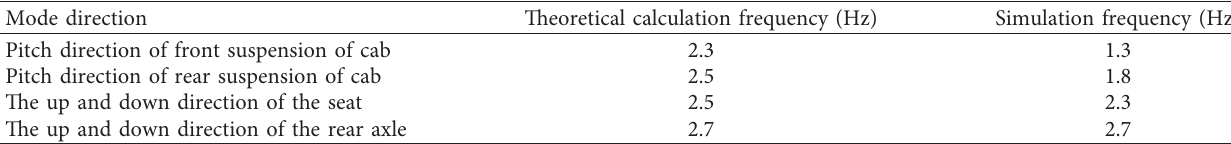
Table 2: Modal frequency between simulation and theoretical calculation.